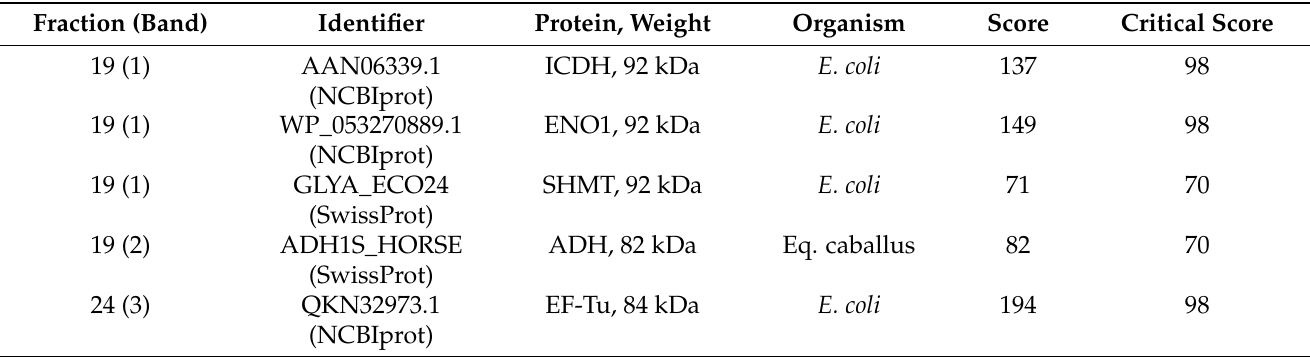
Table 6. Results of mass spectrometry analysis of the bands